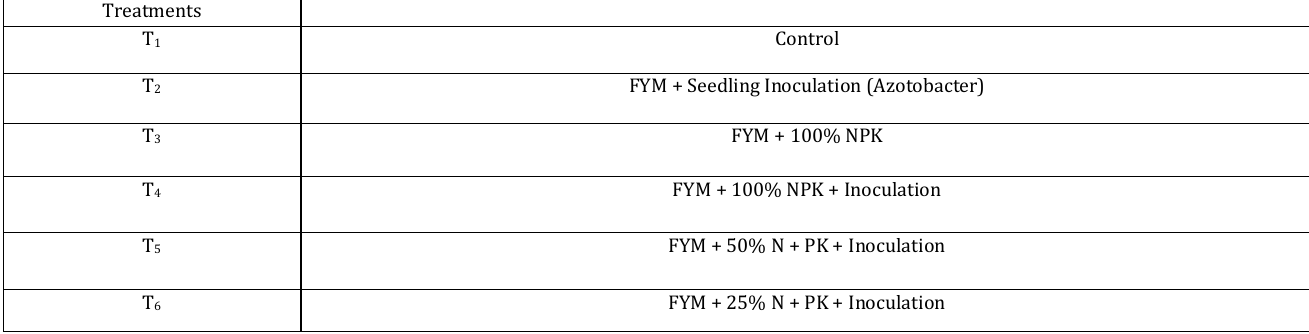
Table 1: Treatments with its